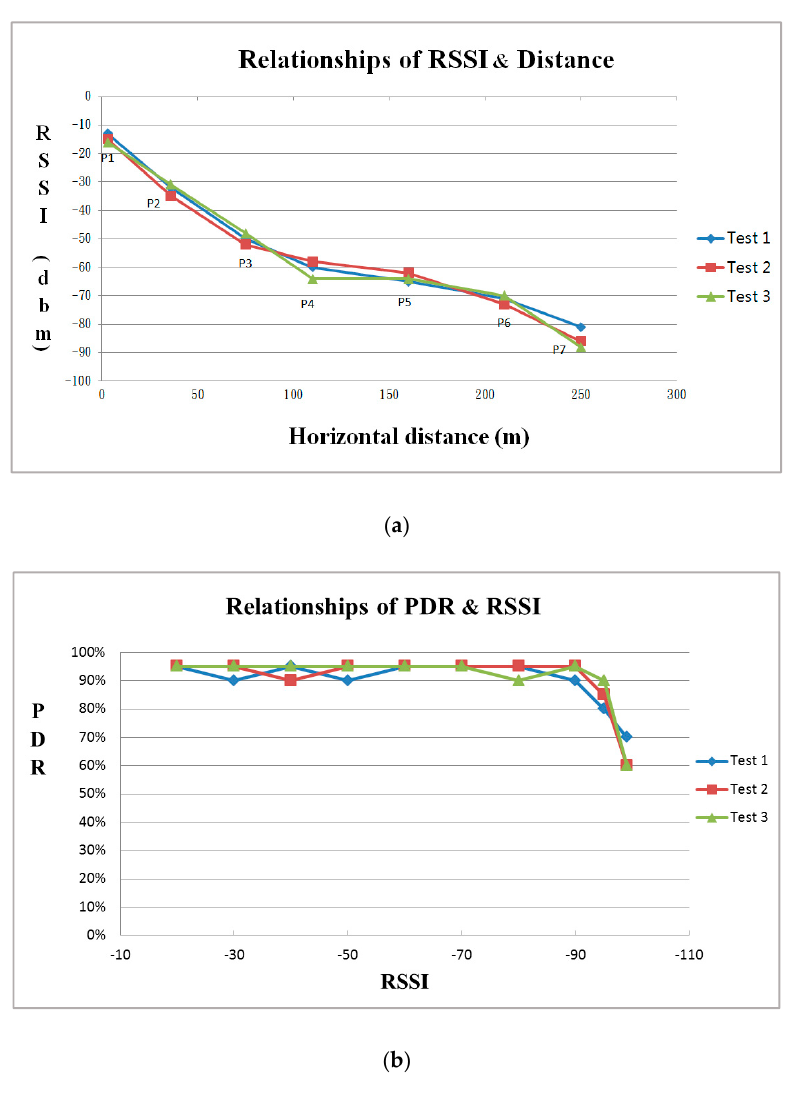
Figure 14 . The relational curve of ( a ) RSSI and distance; ( b ) PDR and RSSI. Figure 14. The relational curve of ( a ) RSSI and distance; ( b ) PDR and